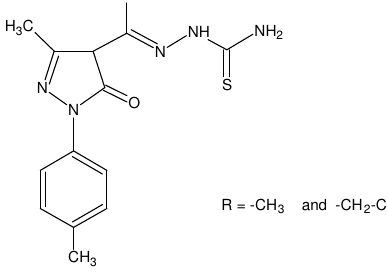
Figure 1 . Pyrazolone